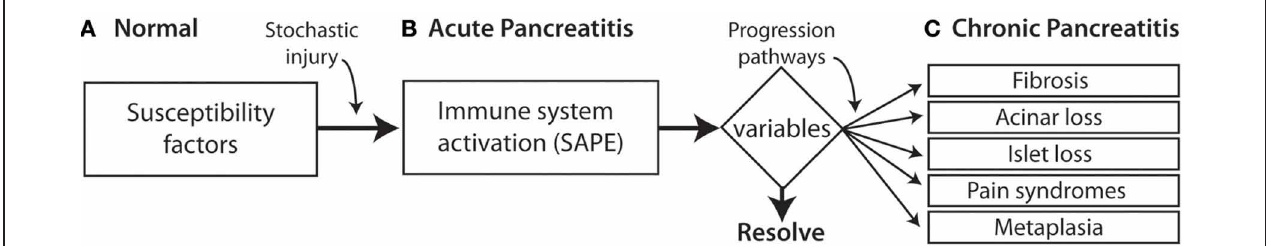
FIGURE 1 | SAPE progression model. (A) Normal histology. Patients may have genetic risk factor and alcoholism but without pancreatic inflammation. (B) Acute pancreatitis is triggered by a stochastic injury (e.g., gallstone) leading to acute pancreatitis with activation of the innate immunes system a recruitment of inflammatory cells. A variety of